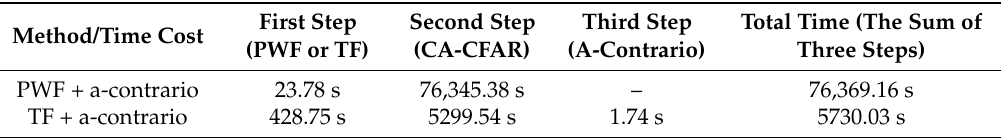
Table 7. Time cost of two methods in Experiment